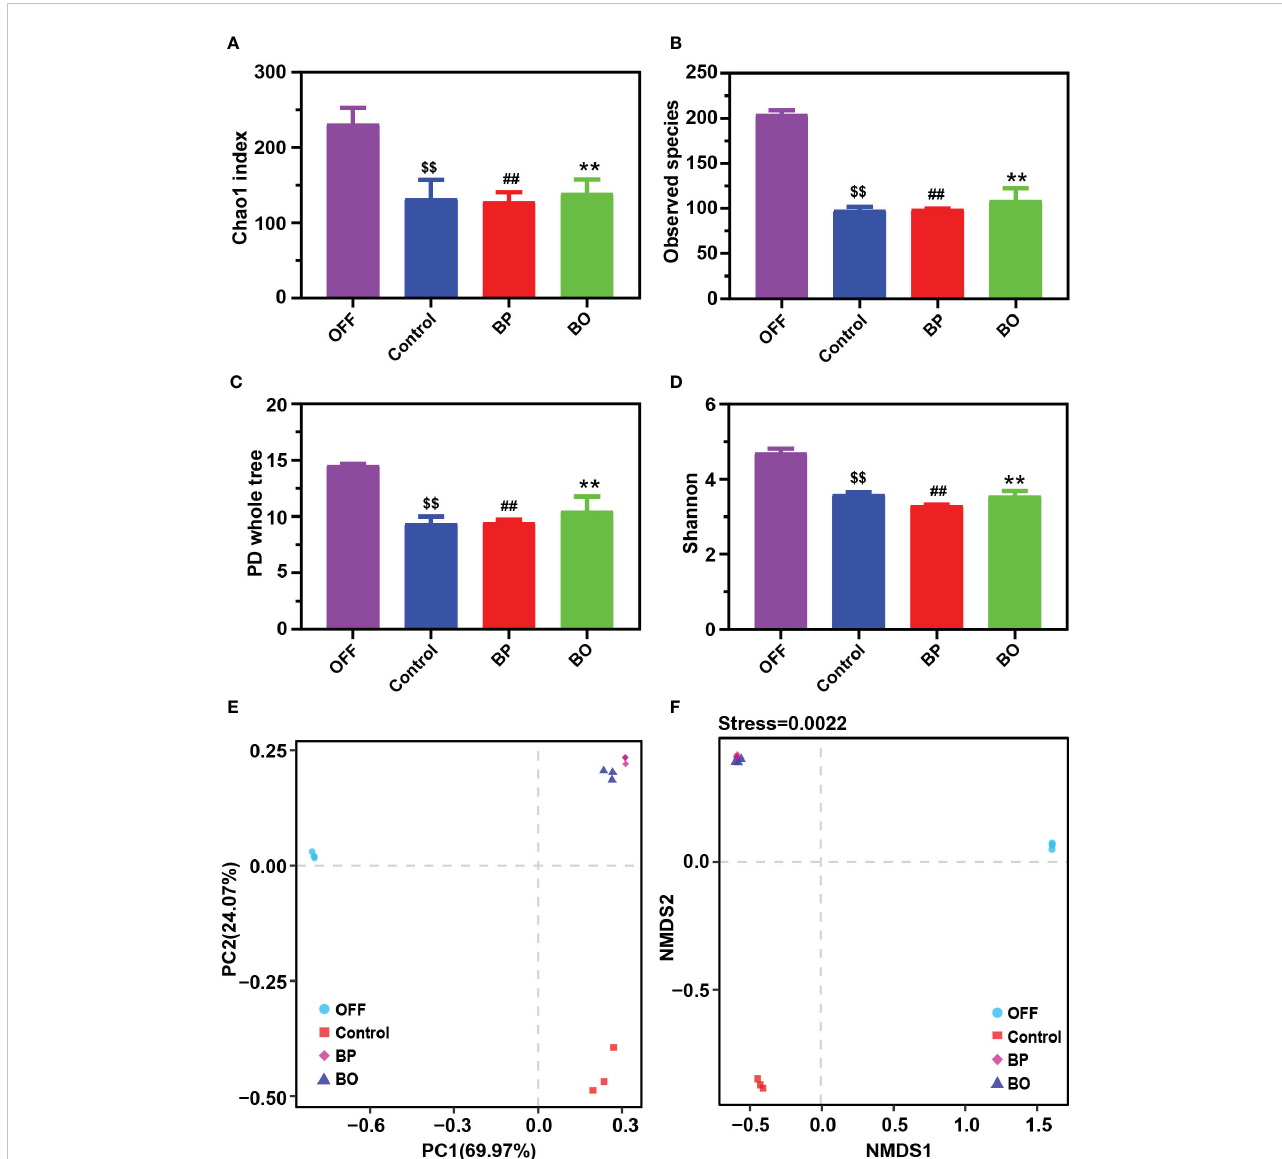
FIGURE 4 Effects of BP and BO on a -diversity and b -diversity of gut microbiota during in vitro fermentation. (A – D) a -diversity analysis of gut microbiota by Chao 1 index (A) , observed species (B) , PD whole tree (C) , and Shannon index (D) . (E, F) b -diversity analysis of gut microbiota by principal component analysis (PCA) and non-metric multidimensional scaling (NMDS) assay. OFF, Original fecal fl ora. Data were shown as mean ± SD (n = 3). $$ p < 0.01, OFF group vs . Control group; ## p < 0.01, OFF group vs. BP group; ** p < 0.01, OFF group vs BO